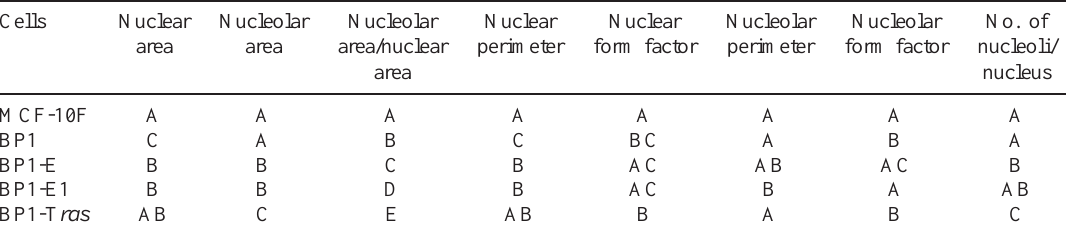
Table 2 Kruskal–Wallis’ test